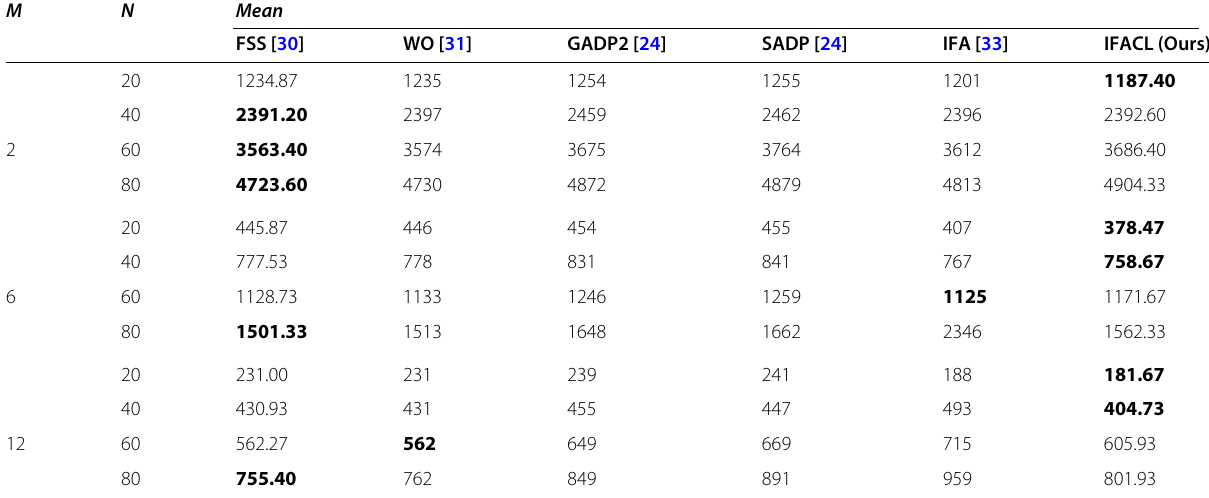
Table 9 Comparison between IFACL and the state-of-the-art in P , SBalanced instances on Dataset2